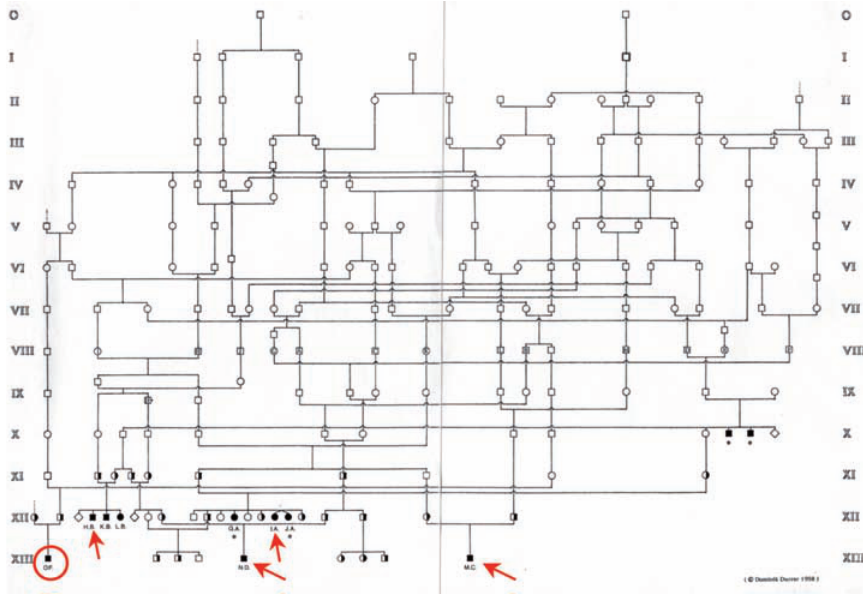
Pedigree of the tribe from the canton of Uri, from 1600 until today Latin numbers represent the generations. Circle: female. Square: male. Filled symbols: individuals who are homozygous for FXIII deficiency and therefore affected by the dis- ease. Semi-filled symbols: individuals who are heterozygous and therefore only carrier of the disease but not affected [17]. The five patients with severe FXIII deficiency taking part in our molecular-genetic analysis are indicated with red arrows (homozygous) or with a red circle (double heterozygous